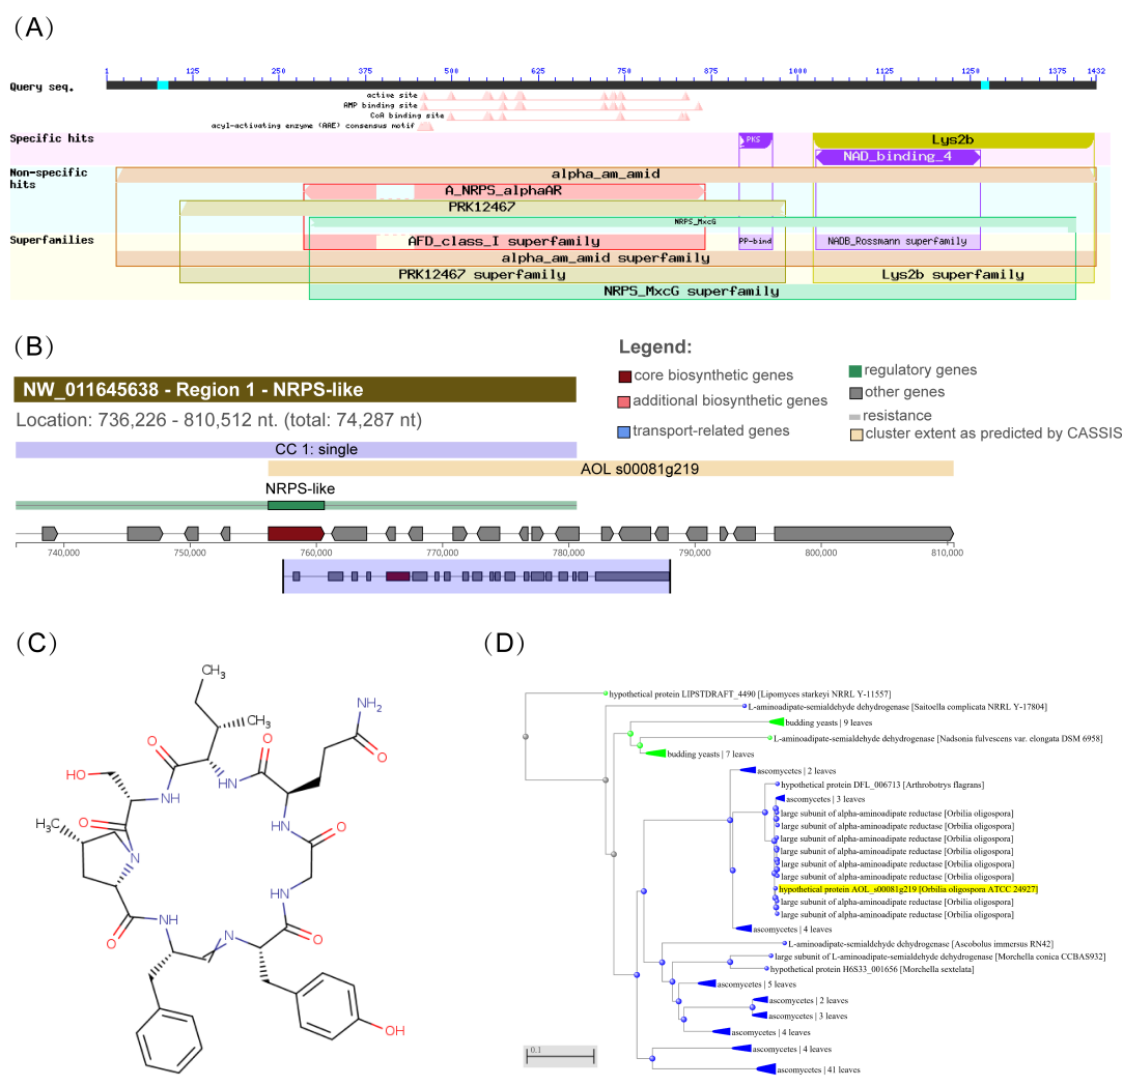
Figure 1. Sequence and phylogenetic analyses of Aoaar . ( A ) Conserved domains of Aoaar from Blastp prediction using amino acid sequence; antiSMASH-predicted biosynthetic gene clusters (NRPS) ( B ) and their predicted core structures ( C ); ( D ) Phylogenetic tree of gene Aoaar .